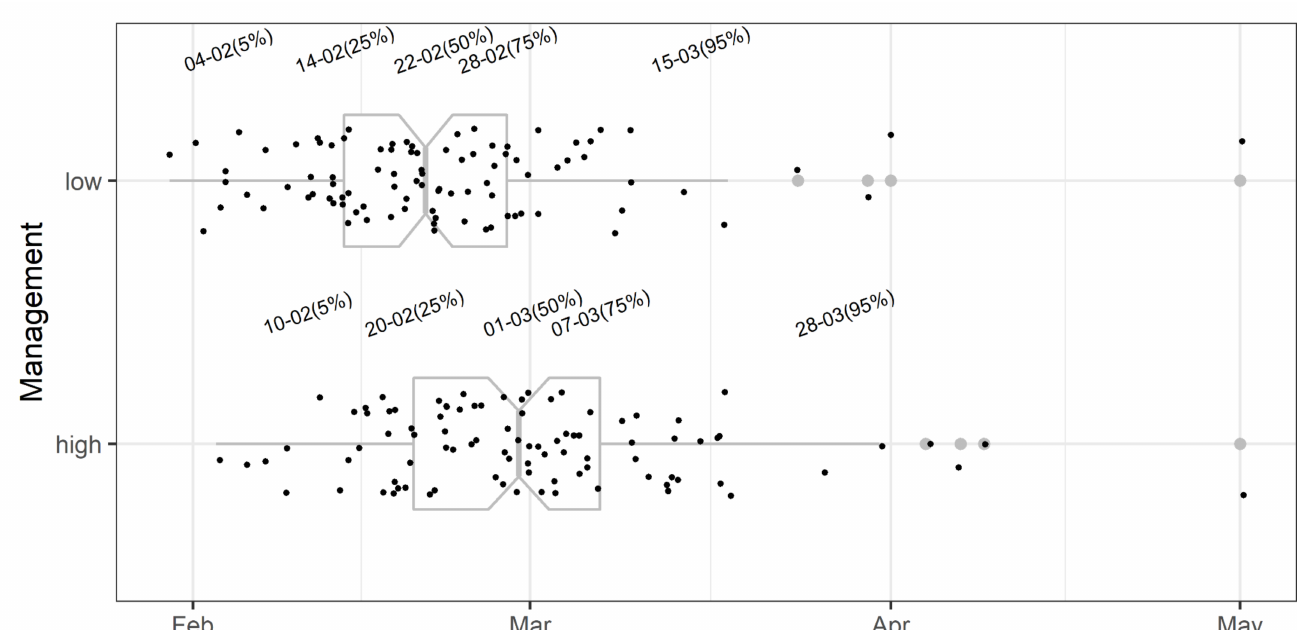
Figure 8. Initial evaluation of the Monilinia vaccinii-corymbosi apothecial presence sub-model in blueberry production systems in northwestern Washington. Points represent the date when the probability of 1% apothecial presence was calculated for low and high management levels in each of 134 environments. Grey boxplots represent the cutoff dates at 5, 25, 50, 75, and 95% across environments, and corresponding grey dots represent the outlier values. Dates (formatted as the day of the month followed by month) above box plots correspond to percentiles of the entire data set for each management